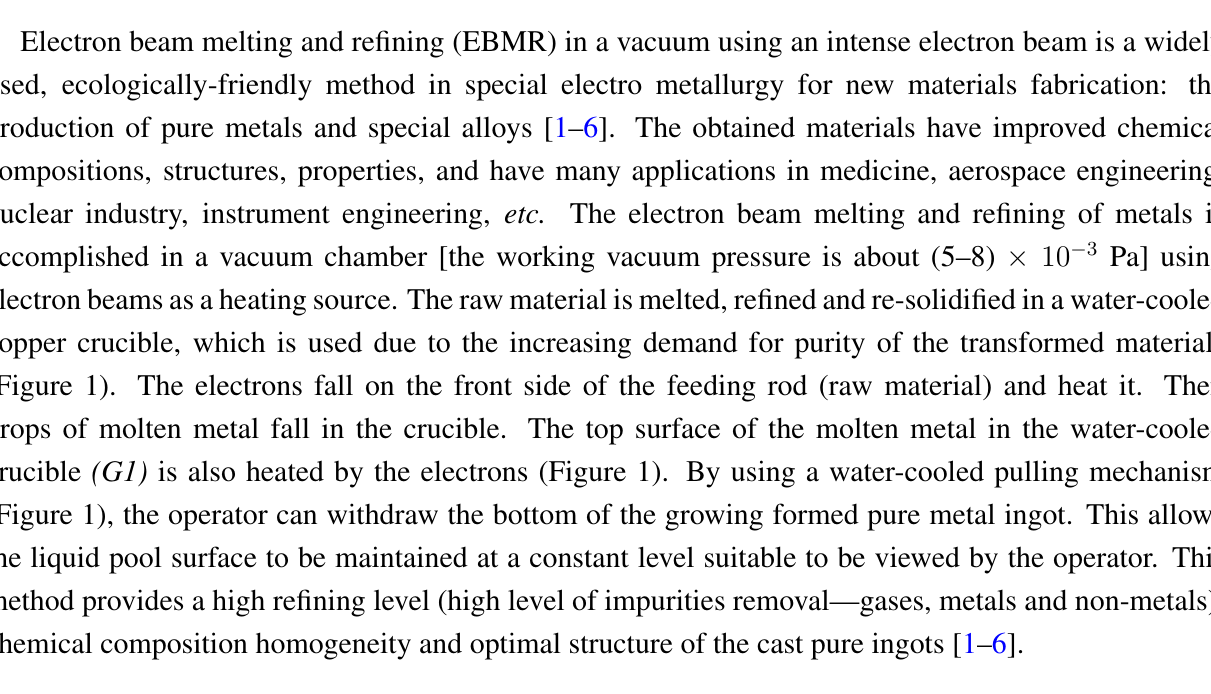
Figure 1. Scheme of Electron beam melting and refining (EBMR) process. G1 —the top surface of the formed pure ingot; G2 —the interface molten ingot/ water-cooled crucible side wall; G3 —the interface ingot/ vacuum; G4 —the interface ingot/water-cooled